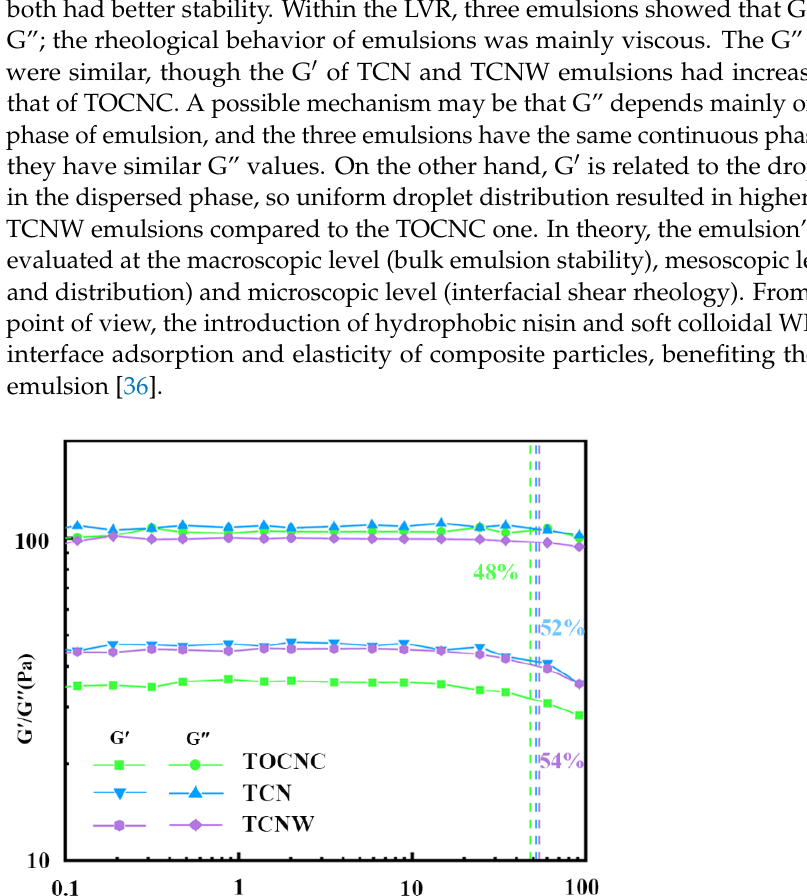
Figure 5. The changes of the storage moduli (G′) and loss moduli (G″) of emulsions.